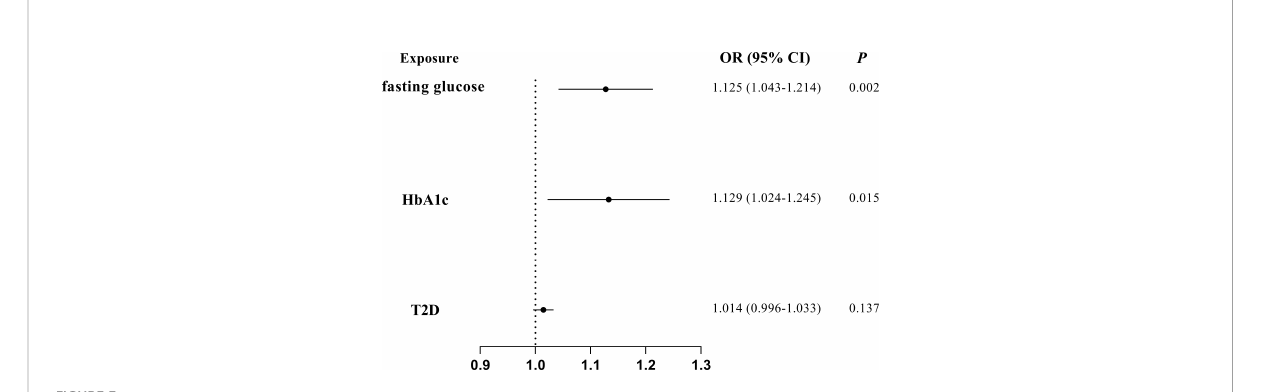
FIGURE 3 MR analyses on the causal association of glycemic traits (fasting glucose, HbA1c, and T2D) with periodontitis after excluding SNPs of BMI. T2D, type 2 diabetes. The error bar indicates the 95% con fi dence